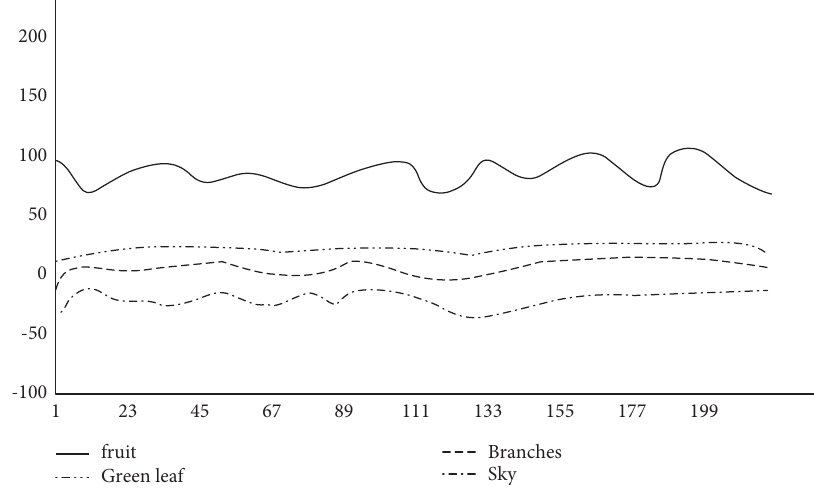
Figure 1: R-G color difference curve of the apple